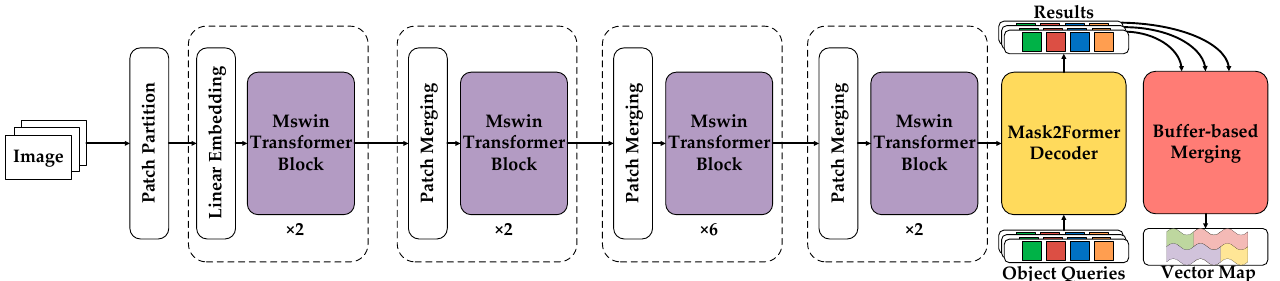
Figure 2. The field area is counted according to three scales: small, medium, and large. The propor- tion of fields of each scale is about 1:3:2.